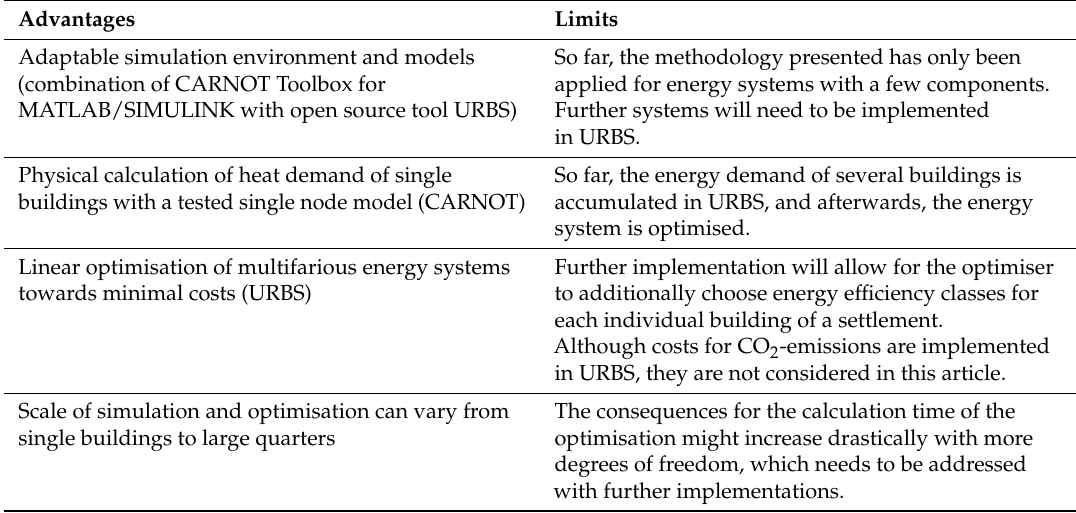
Table 1. Advantages and limits of the methodology applied